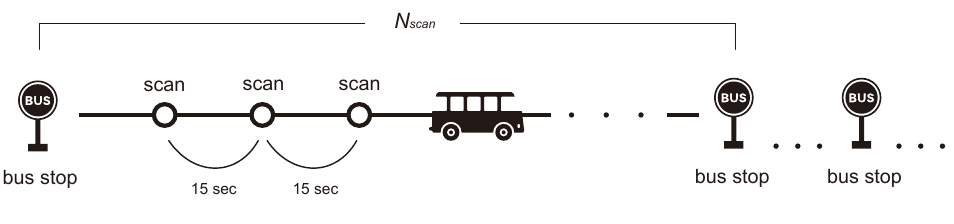
Figure 3. Sensing process.